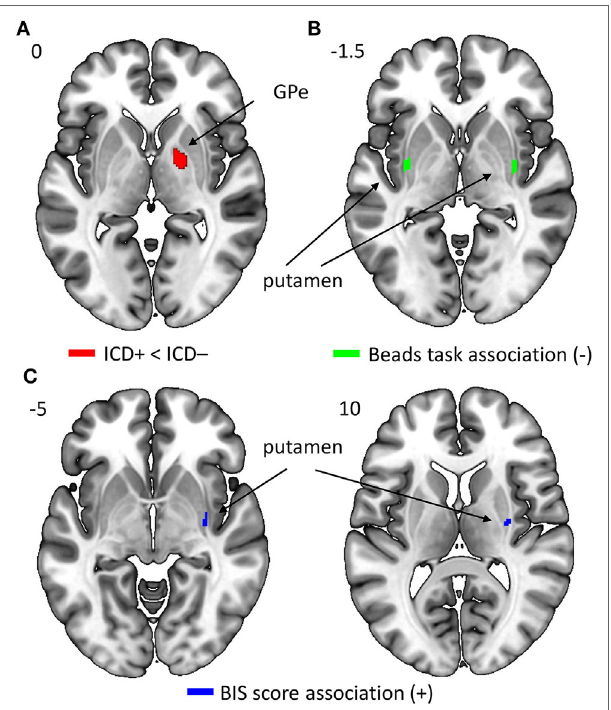
FigUre 5 | Regions in which gray matter (GM) volume was reduced in impulse control disorder (ICD) + compared to that in ICD − patients [right GPe; panel (a) ], in which GM volume was negatively correlated with the average number of draw choices in the beads task [bilateral putamen; panel (b) ], or in which GM volume was positively correlated with Barratt Impulsiveness Scale (BIS) scores [right putamen; panel (c) ].